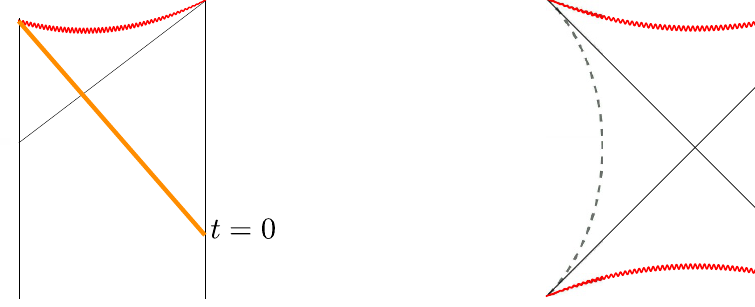
Figure 3 . Left: AdS black hole formed by collapse. Right: conjectured bulk geometry of a typical black hole microstate in a single CFT. The left region makes sense up to a cut-o(cid:11) region (dotted lines) and there is no left